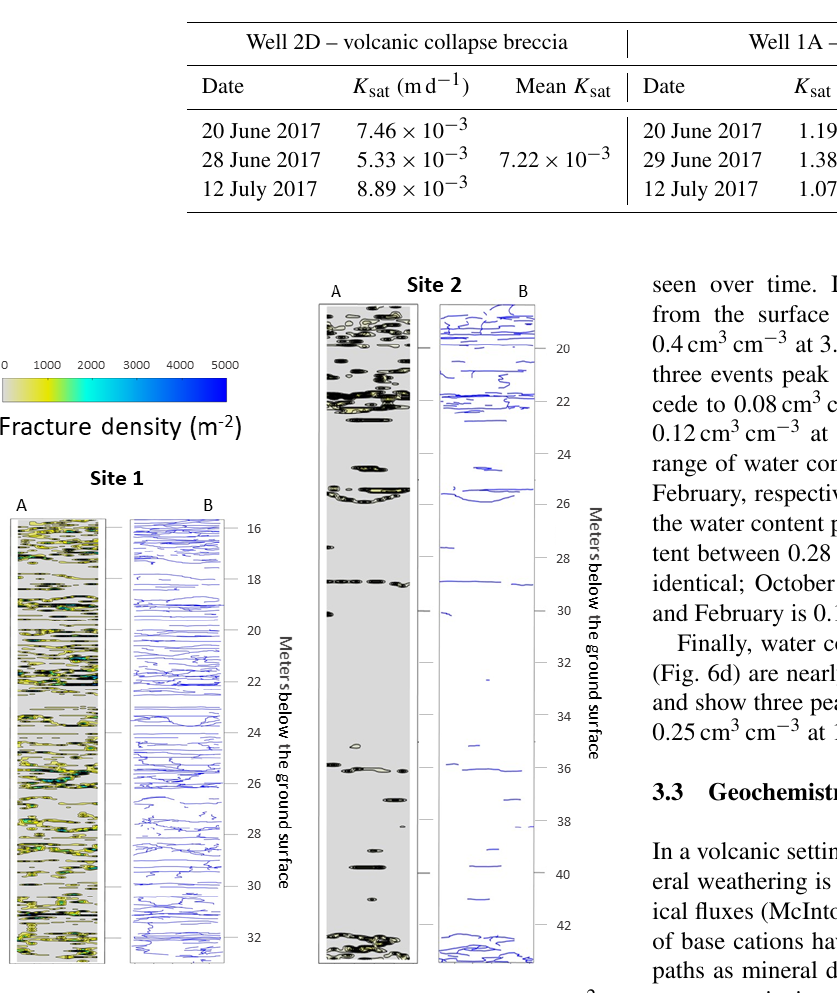
Figure 5. (a) Fracture density of sites 1 (left) and 2 (right) in m − 2 . Notice that fracture density is approximately 5 times greater in site 1 than 2 according to the color scale. (b) Fracture traces of sites 1 (left) and 2 (right) show where fractures exist in meters below the ground